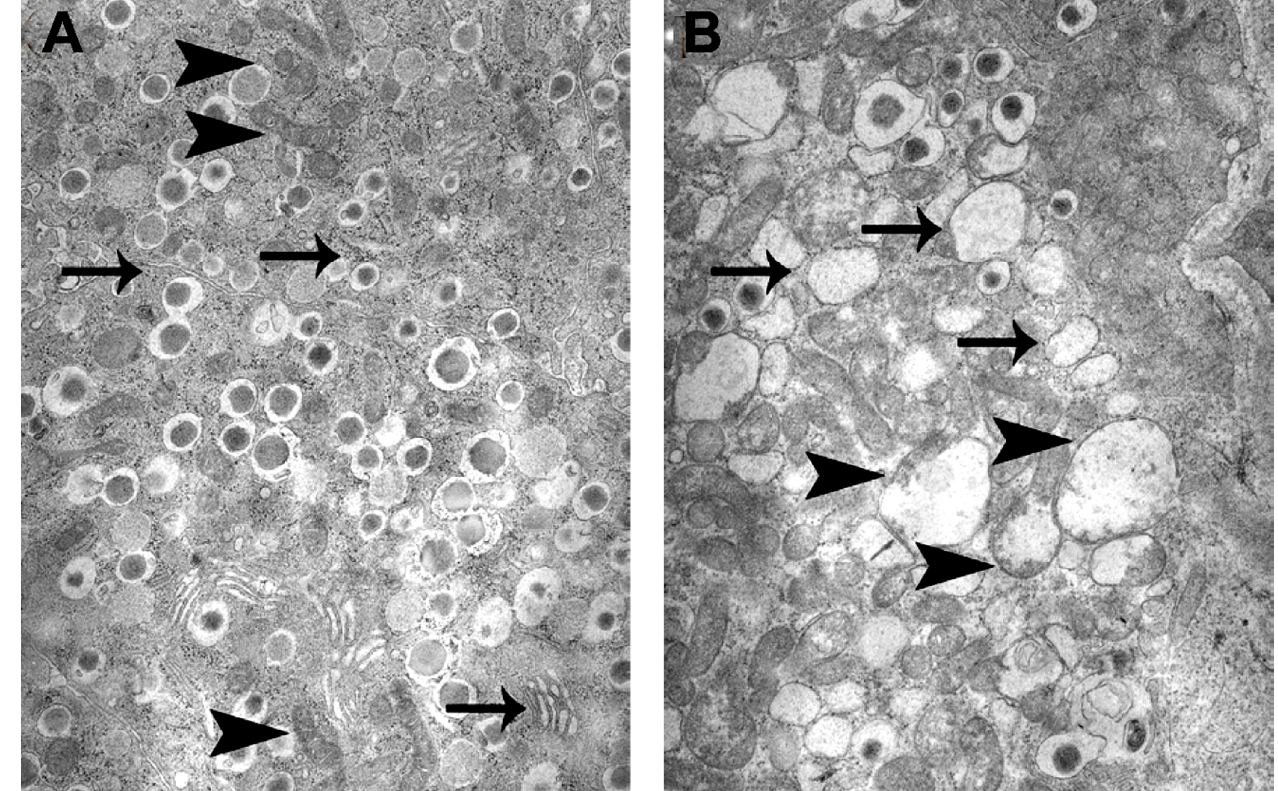
Figure 5. Photomicrographs of pancreas sections of hyperglycemic Cohen diabetic rats [8,10,47]. ( A ) The β -cells in the center of the islets exhibited well-preserved mitochondria (arrow) and nor- mal ER (arrowhead). The β -cells in the periphery of the islets ( B ) showed swollen mitochondria (arrowhead) and dilated ER. EM magnification 18,000 ×